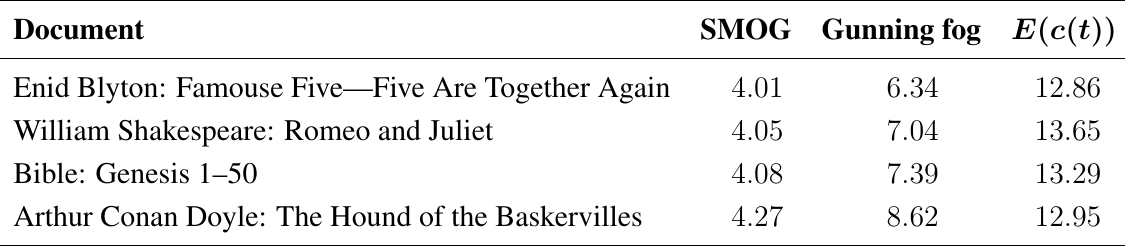
Table 7. SMOG, Gunning fog and expected frequency class for selected